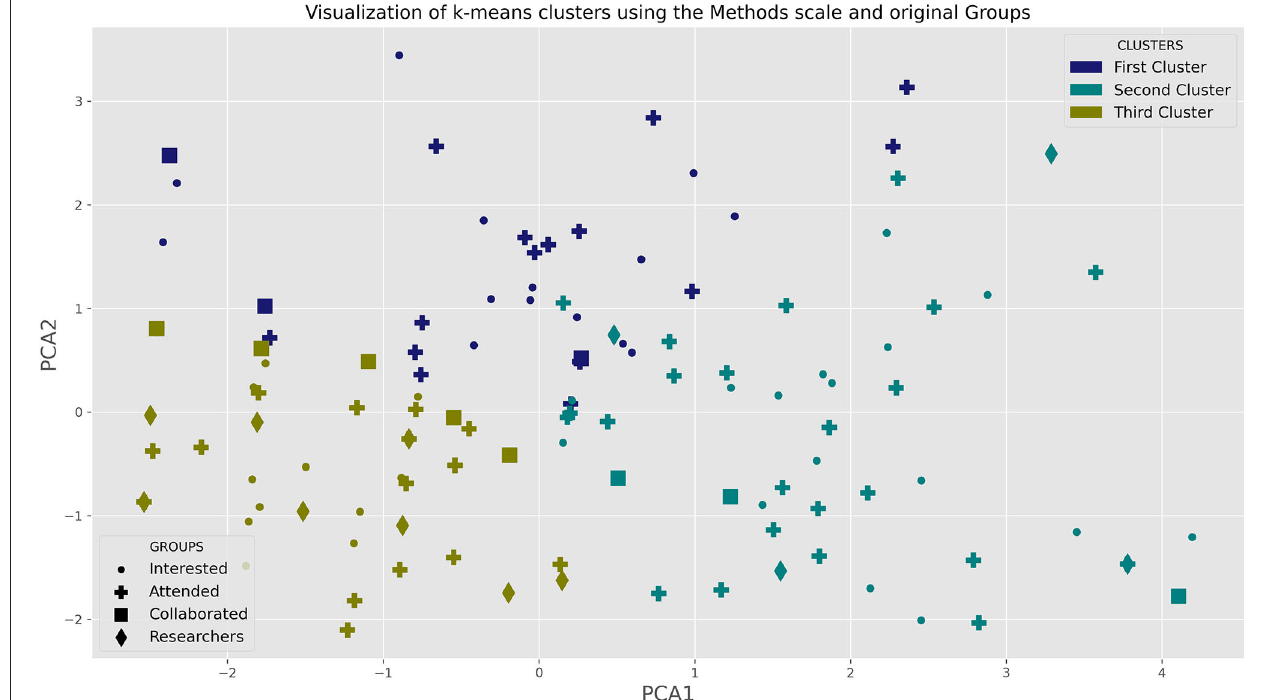
FIGURE 4 | Results of k-means clustering algorithm, projected over the plane spanned by the two first PCA dimensions. The markers represent the groups, whereas the color represents the clusters. In the plane, the lower left corner is associated with the third cluster, the lower right with the second cluster and the upper center with the first cluster. Most members of the RESEARCHERS group (diamond) are in the third cluster, and just a few are in the second cluster with none in the first cluster. Both INTERESTED (points) and ATTENDED (crosses) are more evenly distributed, whereas COLLABORATED (squares), tends to be closer to the RESEARCHERS distribution (it is indistinguishable statistically, see Table 4 ); there are 5 squares in that cluster. Although due to low numbers it is also indistinguishable from the first two groups, notice that whereas in the clustering based on the Neuromyth scale, COLLABORATED and RESEARCHERS were statistically different ( Table 3 ), here they are not.